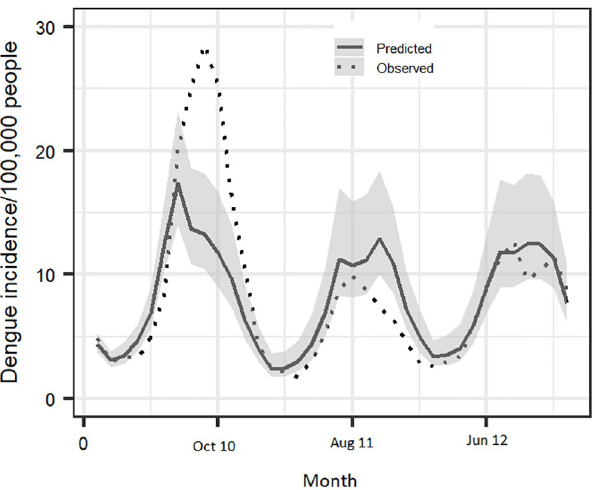
Fig 7. A comparison of the predicted and observed monthly mean incidence of dengue in Vietnam in 2010–2012 (36 months).